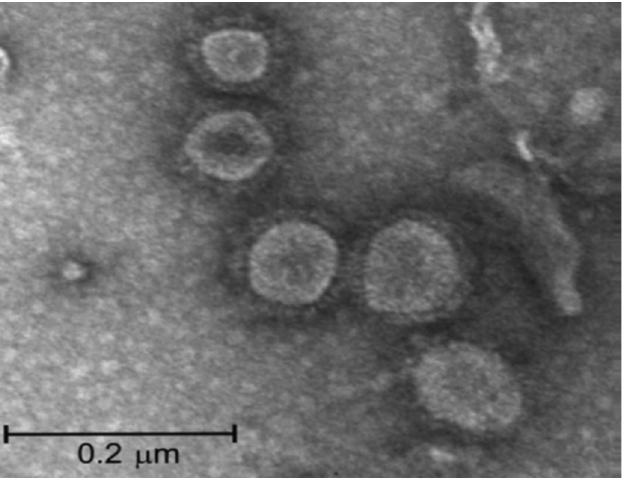
Figure 1. Image of H6-type influenza VLPs detected by transmission electron microscopy using negative staining. (Adapted from Smith et al., 2020 [116]).